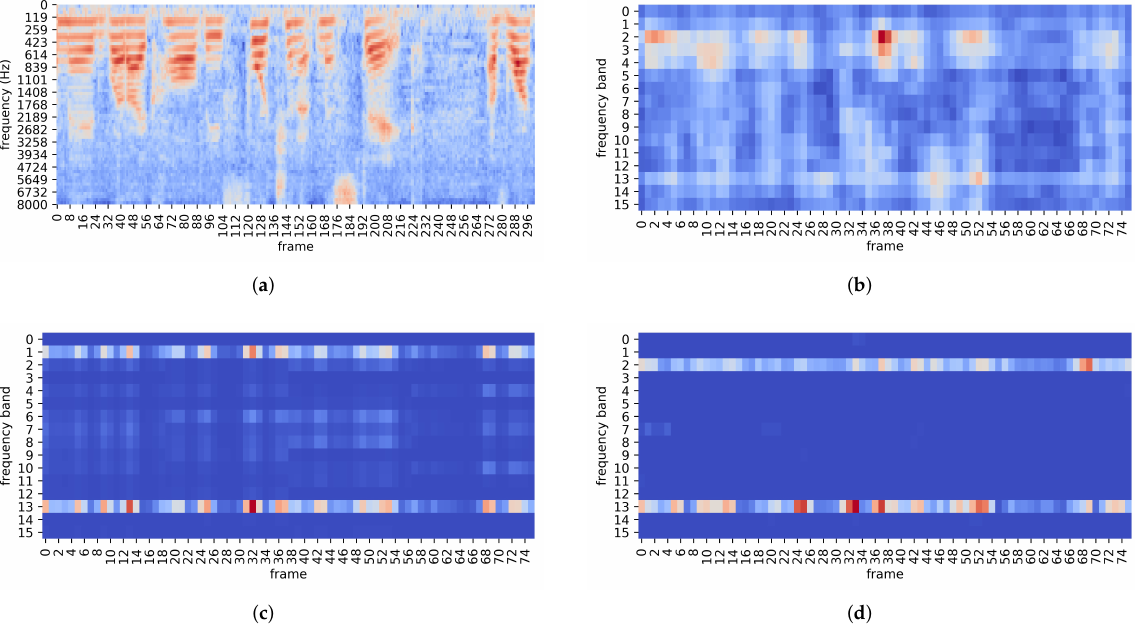
Figure 5. Visualization of the intermediate results of CNN-based SV systems: ( a ) log Fbank coef- ficients, ( b ) the mean of frame-level features in the ASP-SGFSAP-1 system, ( c ) the attention map generated by SAP-SGFSAP-19, ( d ) the attention map generated by